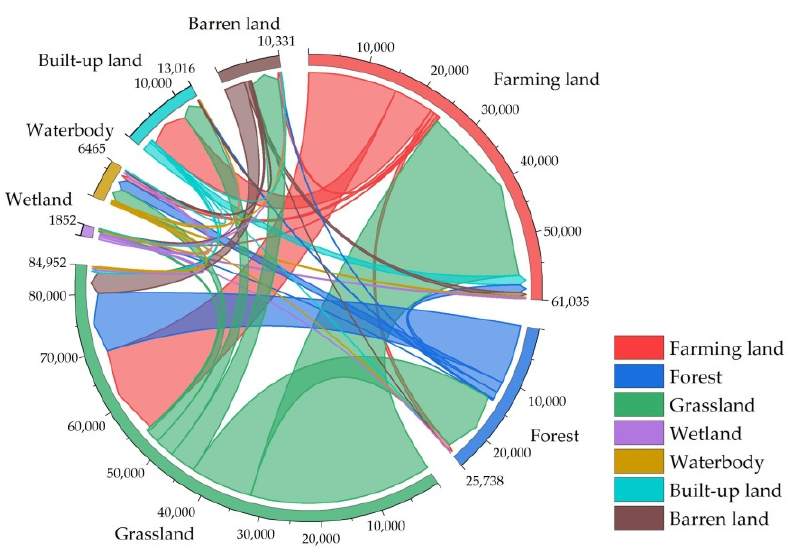
Figure 4. Land use conversion direction from 2010 to 2020.